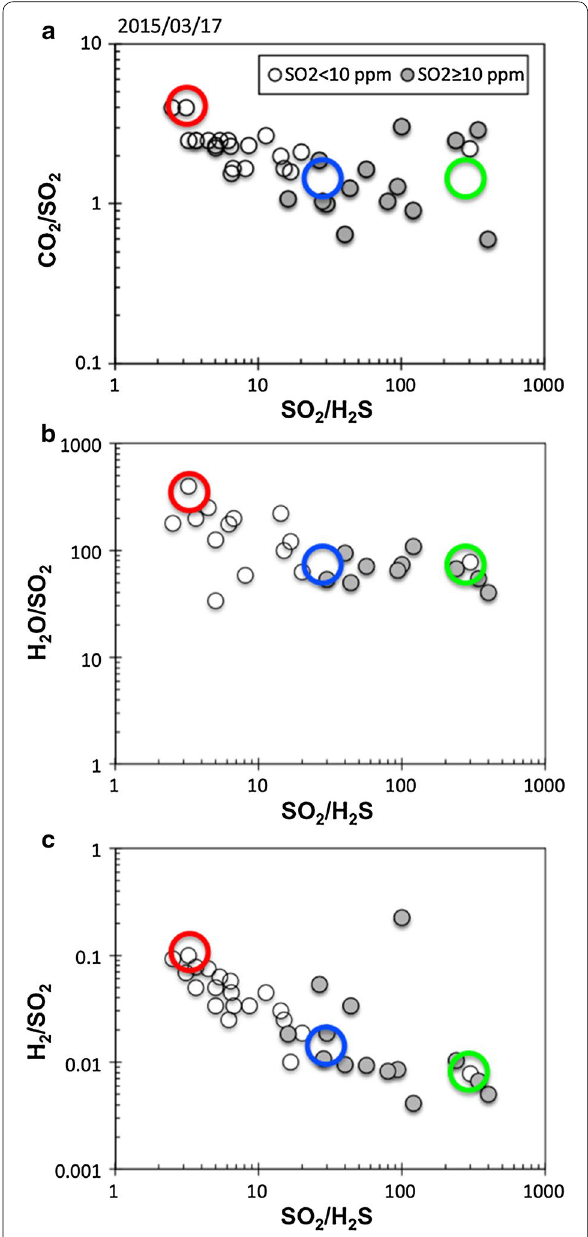
Fig. 10 Correlation of gas concentration molar ratios on 17 March 2015. a correlation of CO 2 /SO 2 molar ratio with SO 2 /H 2 S molar ratio, b correlation of H 2 O/SO 2 molar ratio with SO 2 /H 2 S molar ratio, and c correlation of H 2 /SO 2 molar ratio with SO 2 /H 2 S molar ratio. Grey circles show ratios obtained for high concentration peaks of SO 2 ppm, and white circles are ratios of low concentration peaks of SO 2 < 10ppm. Red, blue and green circles indicate the compositions A”, B” and C”,